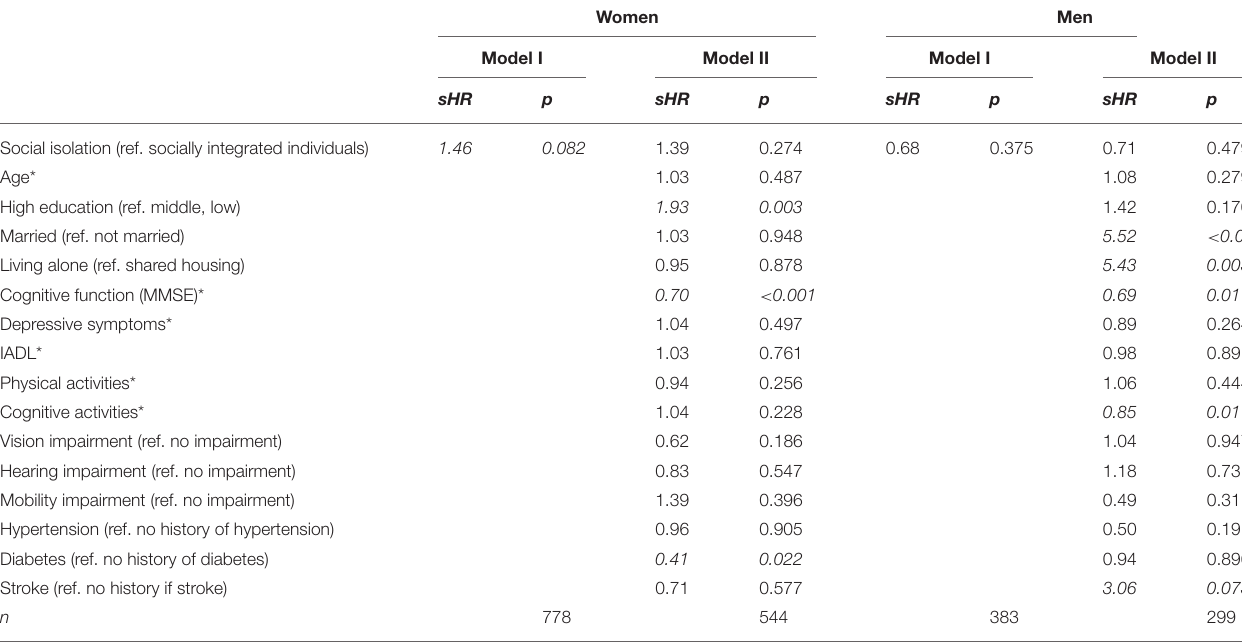
TABLE 3 | Univariate and multivariate Fine and Gray (competing risk) regression model for the impact of social isolation on incident dementia by